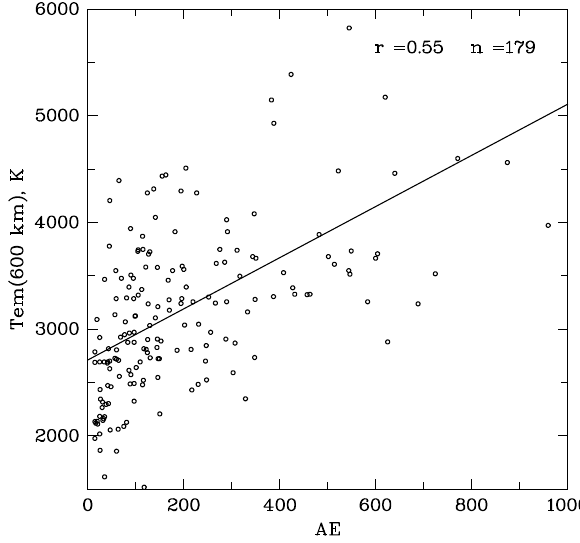
Fig. 3. Changes in the magnitude of the temperature peak with the level of magnetic activity. Shown is a scatter plot of the maxi- mum temperatures T em as a function of the hourly averaged AE index. These temperatures have been adjusted to a common al- titude of 600 km. Also shown is the respective regression line: T em [ K ]= 2712 + 2 . 4 · AE